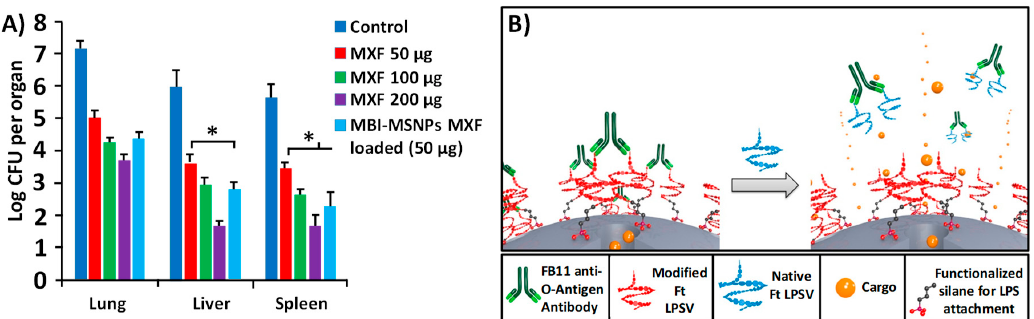
Figure 6. ( A ) In vivo efficacy of 1-methyl-1H-benzimidazole (MBI)-MSNPs loaded with moxifloxacin (MXF), assessed by an assay of F. tularensis burden in the mouse organs. Post-infection, mice were treated with free MXF or with MXF-loaded MBI-MSNPs by tail vein injection on days 1, 3, and 5. Mice were euthanized one day after the last dose of treatment (day 6) to enumerate the bacterial numbers in the lung, liver, and spleen (adapted with permission from [110], copyright American Chemical Society 2015). ( B ) Schematic representation of the triggered release of cargo due to a competitive displacement of the antibody (green) that caps the pore by naturally occurring F. tularensis lipopolysaccharide (LPS) (blue) (adapted with permission from [111], copyright American Chemical Society